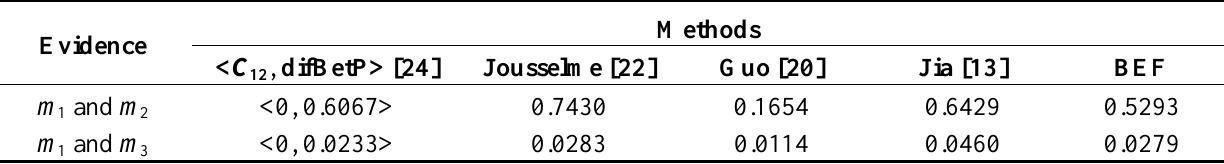
Table 3. Contrast results of different dissimilarity measurement